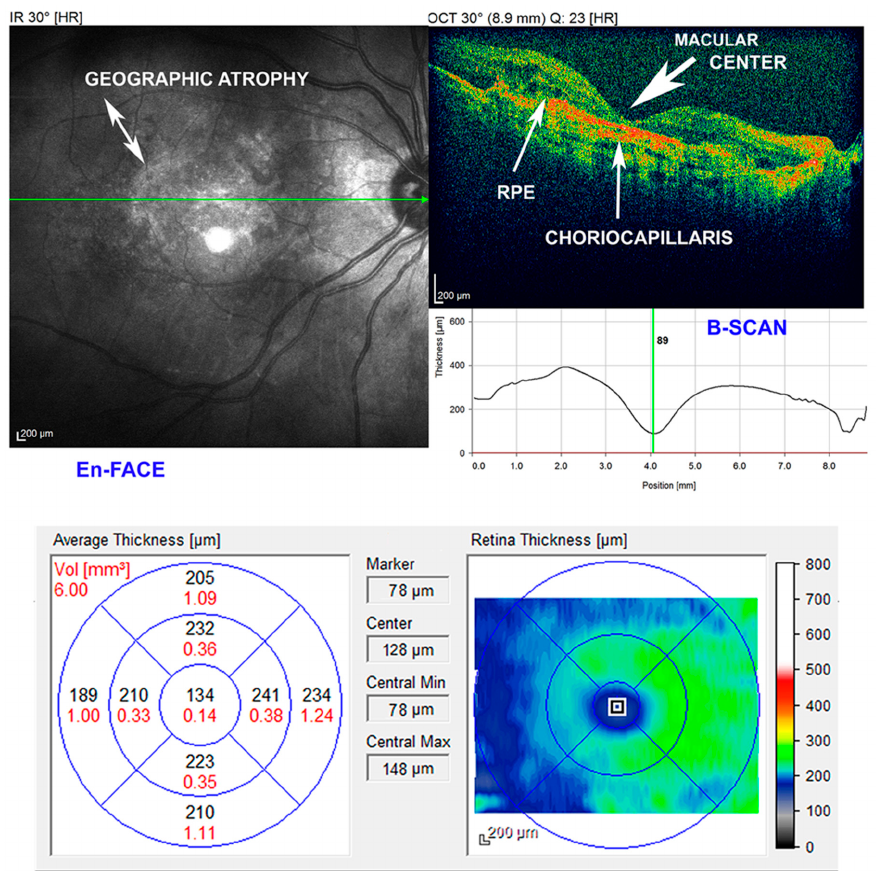
Figure 1. Imaging of geographic atrophy (GA). En-face and B-scan spectral-domain optical coherence tomography (SD-OCT). Decreased macular thickness (center marker 89/78 µm), retinal pigment epithelial (RPE) irregularities, and of the underlying choriocapillaris. The atrophic area shows hyperreflective clumps at different levels, segmented plaques of the outer band and elevations with variable reflectivity. GA is a form of advanced dry age macular degeneration (AMD). An eye may have uni- or multi-focal atrophic lesions, which, when summed, determine the central total lesion area. Scale bars = 200 µ